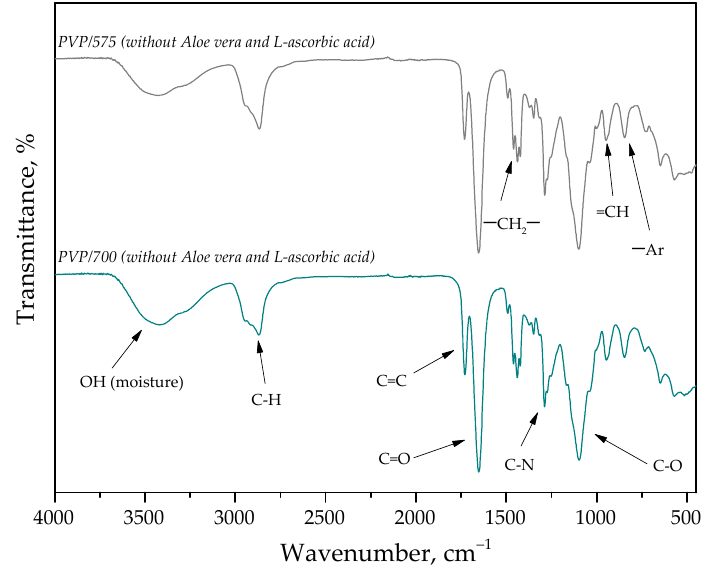
Figure 15. FT-IR spectra of PVP-based hydrogels without any additives.